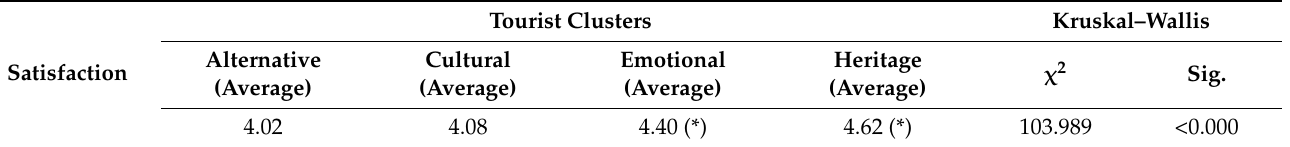
Table 5. Satisfaction analysis of tourist